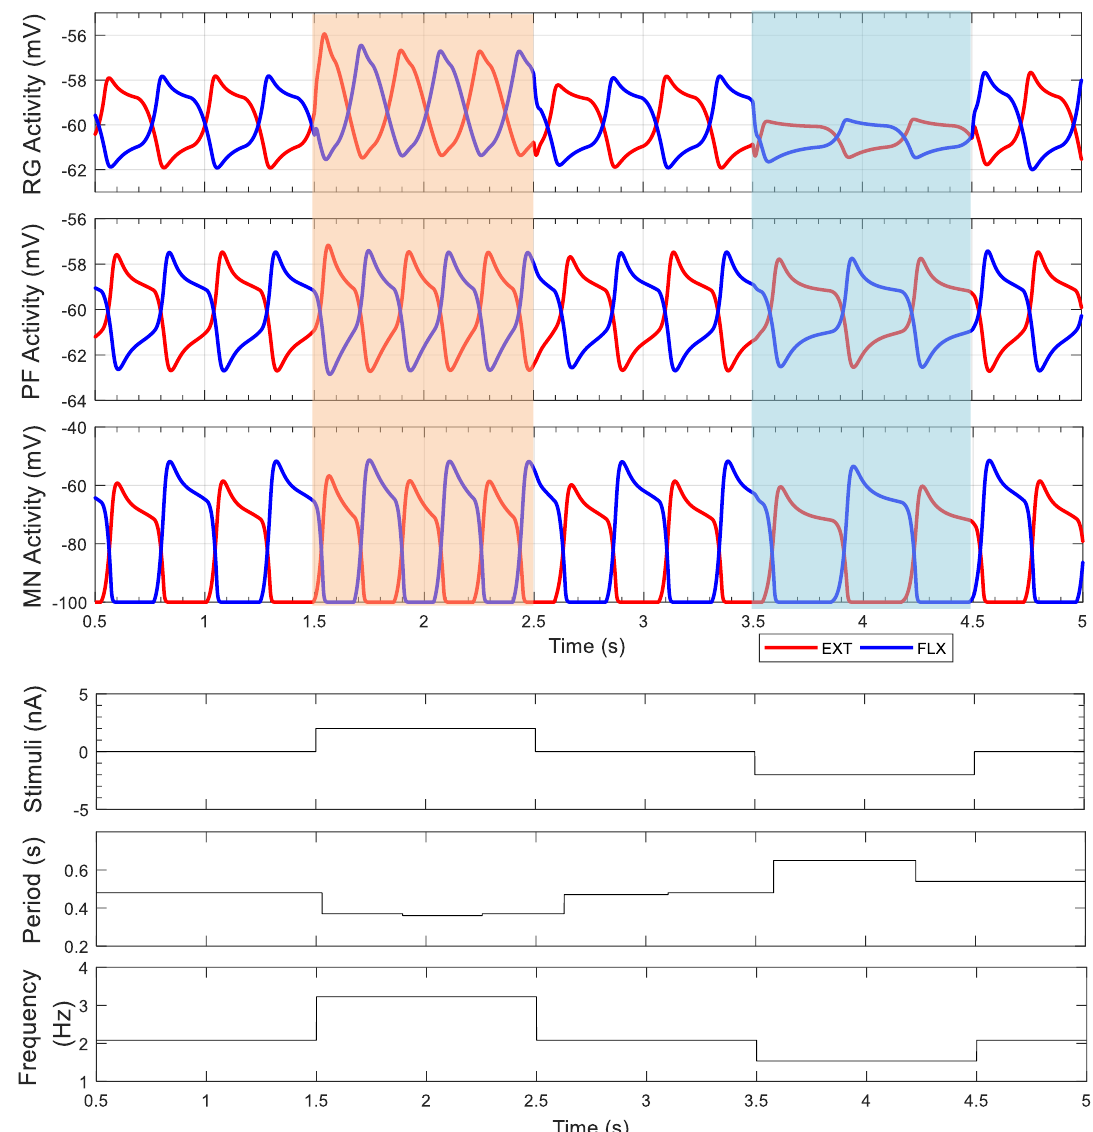
Figure 5. Rhythm generator performance under different conditions. Excitatory stimulus applied from 1.5 to 2.5 s (orange area) with a current of 2 nA. Inhibitory stimulus applied from 3.5 to 4.5 s (blue area) with a current of − 2 nA. Both stimuli applied to extensor and flexor rhythm generator neurons simulate descending signals from the midbrain locomotor region. The simulation startup transient, corresponding to the first 0.5 s is not shown. EXT: Extensor; FLX: Flexor; MN: Motoneuron; PF: Pattern formation; RG: Rhythm generation.